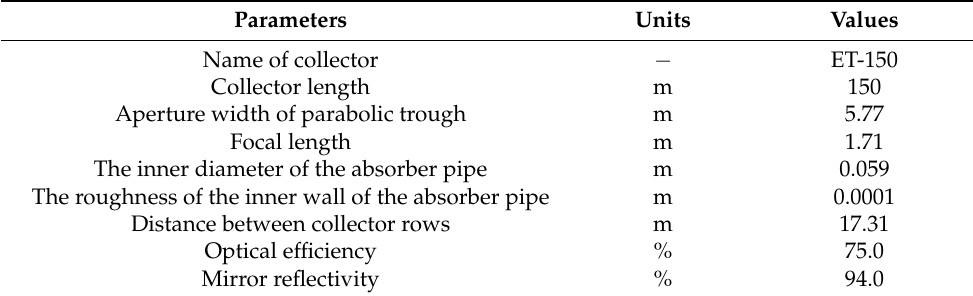
Table 1. Main technical specifications of EuroTrough-150 collector. Parameters Units